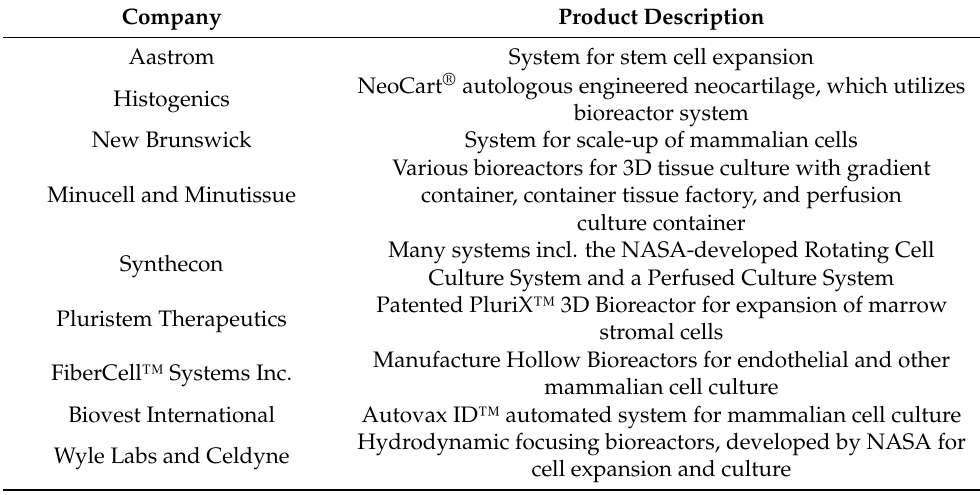
Table 6. List of companies and commercial bioreactor